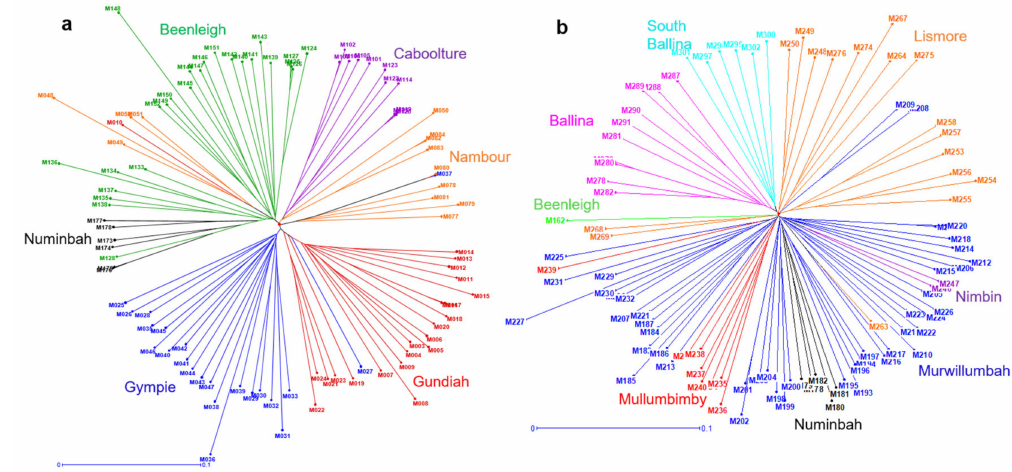
Figure 4. Unweighted neighbour-joining dendrograms using 2872 SNP markers, showing the genetic relationships among ( a ) 99 M. integrifolia accessions and ( b ) 94 M. tetraphylla accessions. Localities are represented by di ff erent